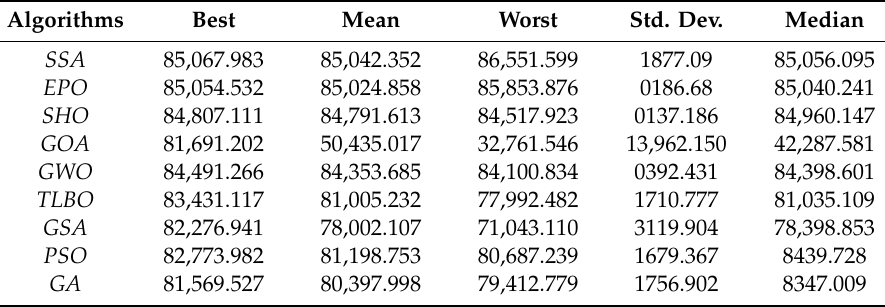
Table 14. Statistical results for Rolling element bearing design